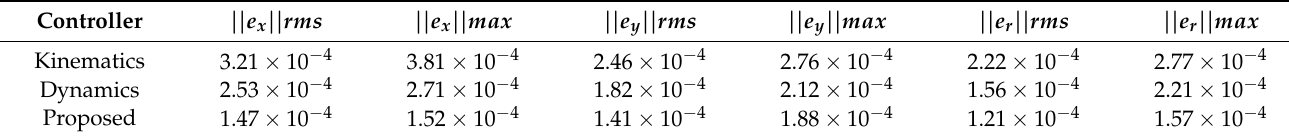
Figure 8. The S type trajectory tracking error performance. Table 2. The S type trajectory tracking error values for the three